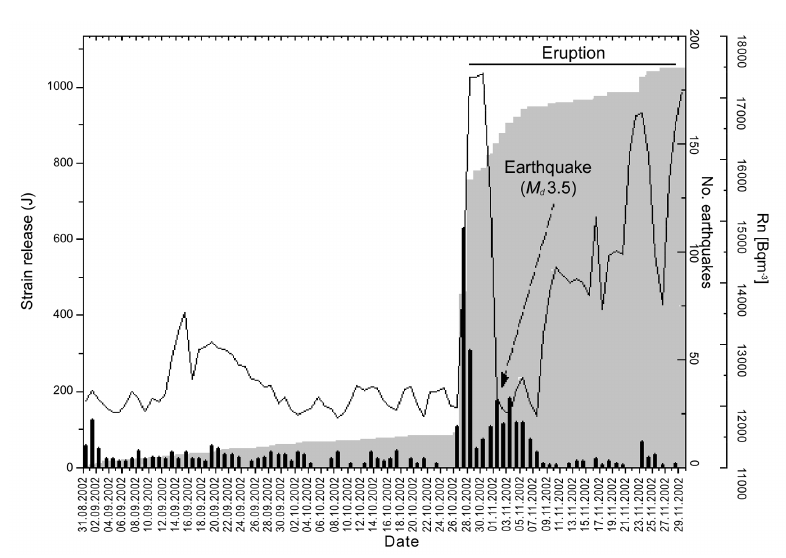
Fig. 4. Radon concentration (black line), daily earthquakes rate (black column bar) and strain release (grey his- togram) measured in the period between 1st September 2002 and 30th November 2002 (Vena